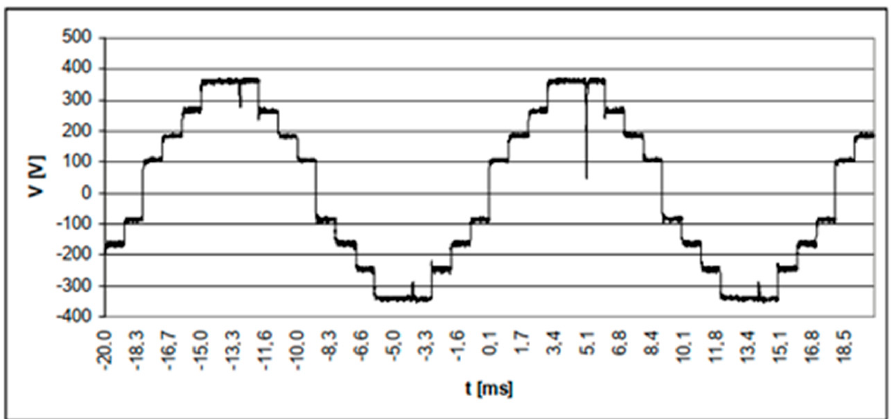
Figure 7. The phase voltage waveform of the OVT inverter gained during experimental tests.